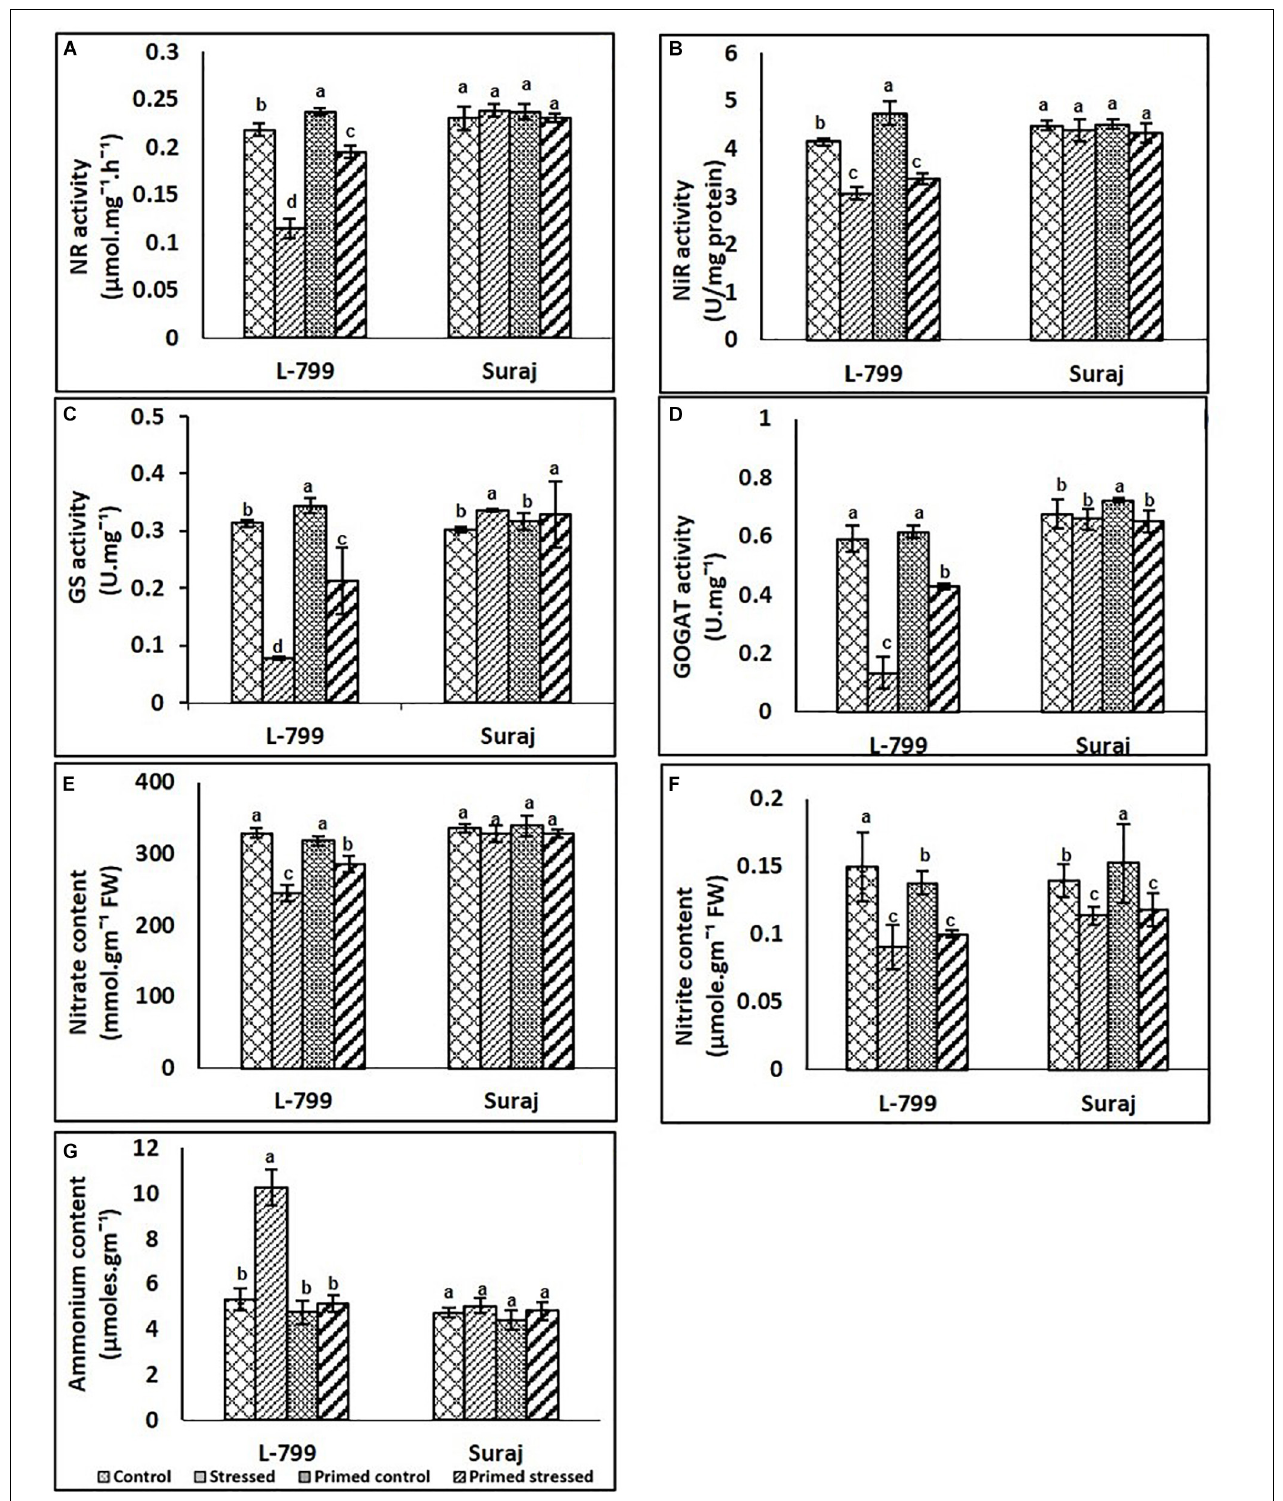
FIGURE 9 | Effects of melatonin priming on the nitrogen cycle (A–G) of two drought distinguished cotton varieties, L-799 and Suraj, under drought stress or well-watered conditions. (A) Nitrate reductase (NR), (B) nitrite reductase (NiR), (C) glutamine synthase content (GS), (D) glutamate synthase activity (GOGAT), (E) nitrate, (F) nitrite, and (G) ammonium contents. Data represent mean values ± SD of 3 independent experiments. Different alphabets within the group represent significant differences among treatments according to Duncan multiple range test at P < 0.05.